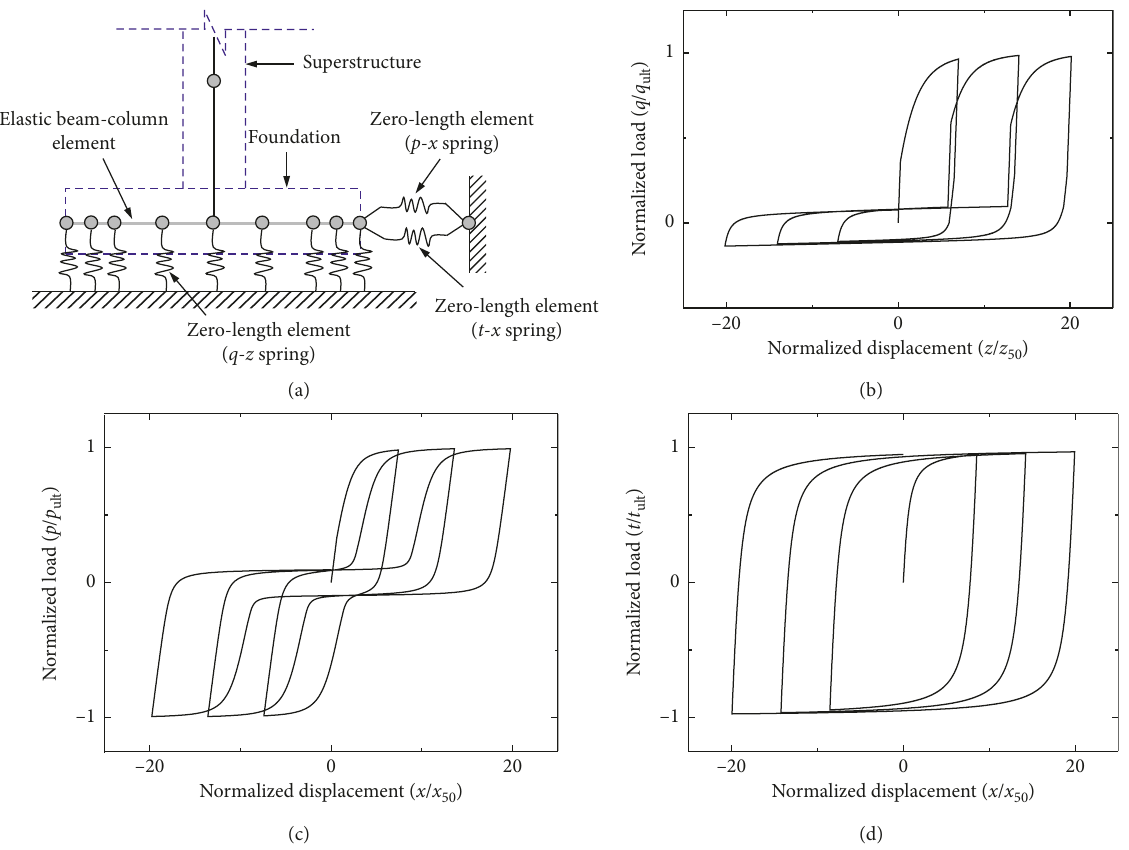
Figure 4: The BNWF model and behavior of soil spring for the foundation. (a) The BNWF model. Behavior of (b) q-z model, (c) p-x model, and (d) t-x